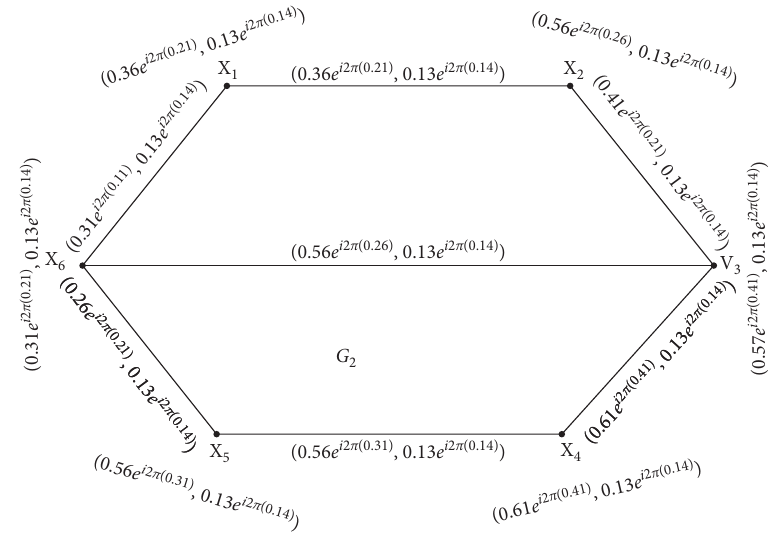
Figure 12: Complex q-rung orthopair fuzzy dual graph G